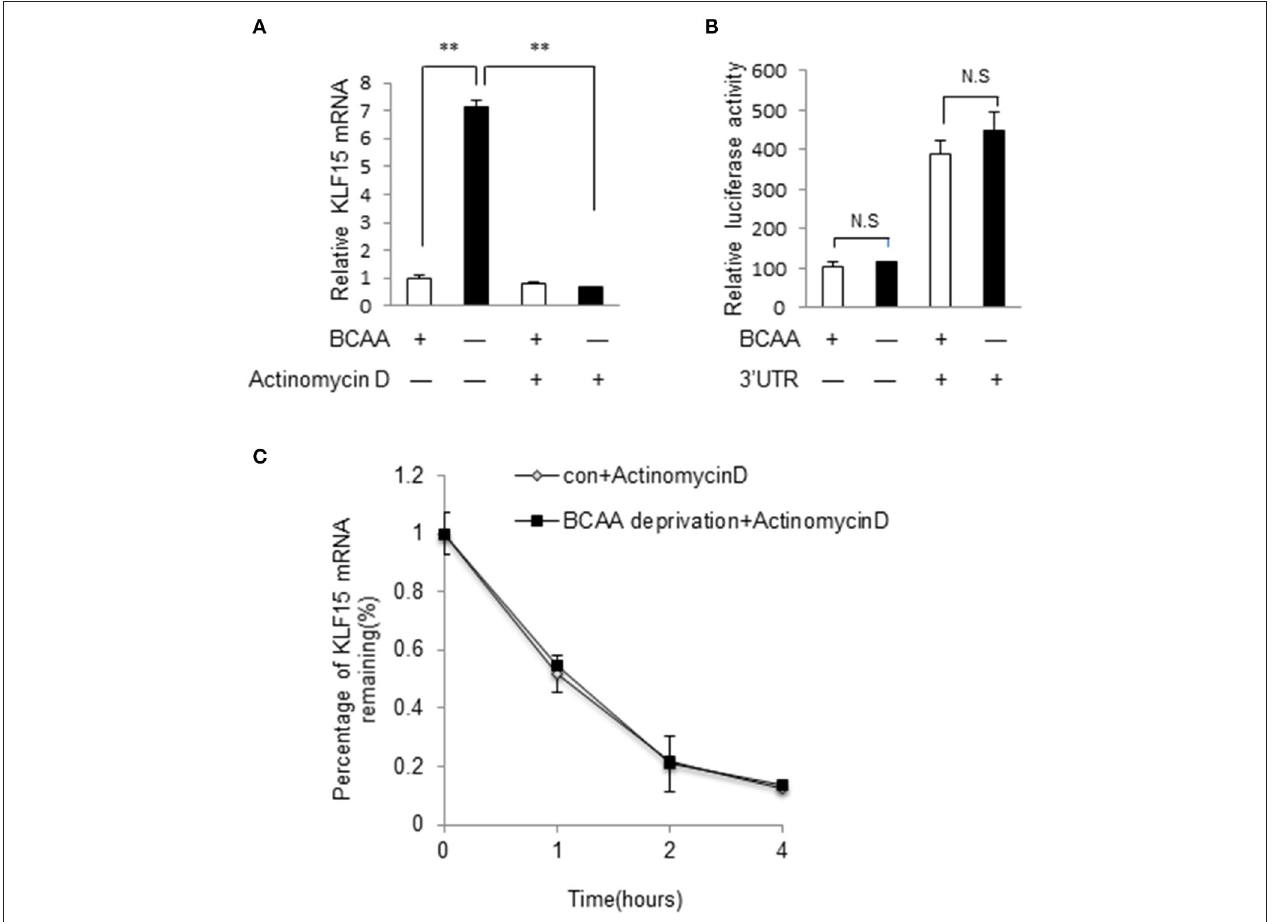
FIGURE 5 | BCAA regulates KLF15 expression at transcriptional level. (A) Quantitative PCR was performed to measure the mRNA level of KLF15 in cells pretreated with actinomycin D (5 µ g/ml) or DMSO for 30min before BCAA starvation ( − ) for 6h. (B) Luciferase assay results from MEF cells transfected with luciferase reporter vectors with ( + ) or without ( − ) KLF15 3’UTR with ( + ) or without BCAA ( − ). (C) Quantitative PCR was performed to measure the relative mRNA level of KLF15 in cells treated with actinomycin D (5 µ g/ml) for indicated time in the presence (con) or absence of BCAA (BCAA starvation). Data are means ± SE for three individual samples. ** p <